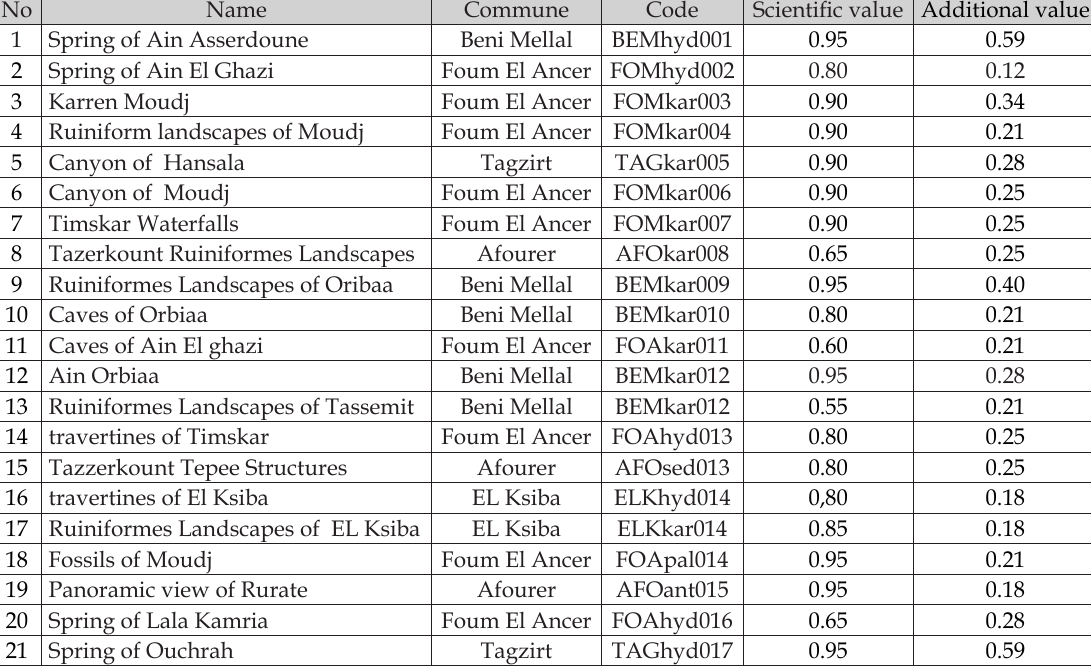
Table 2. list of selected and evaluated